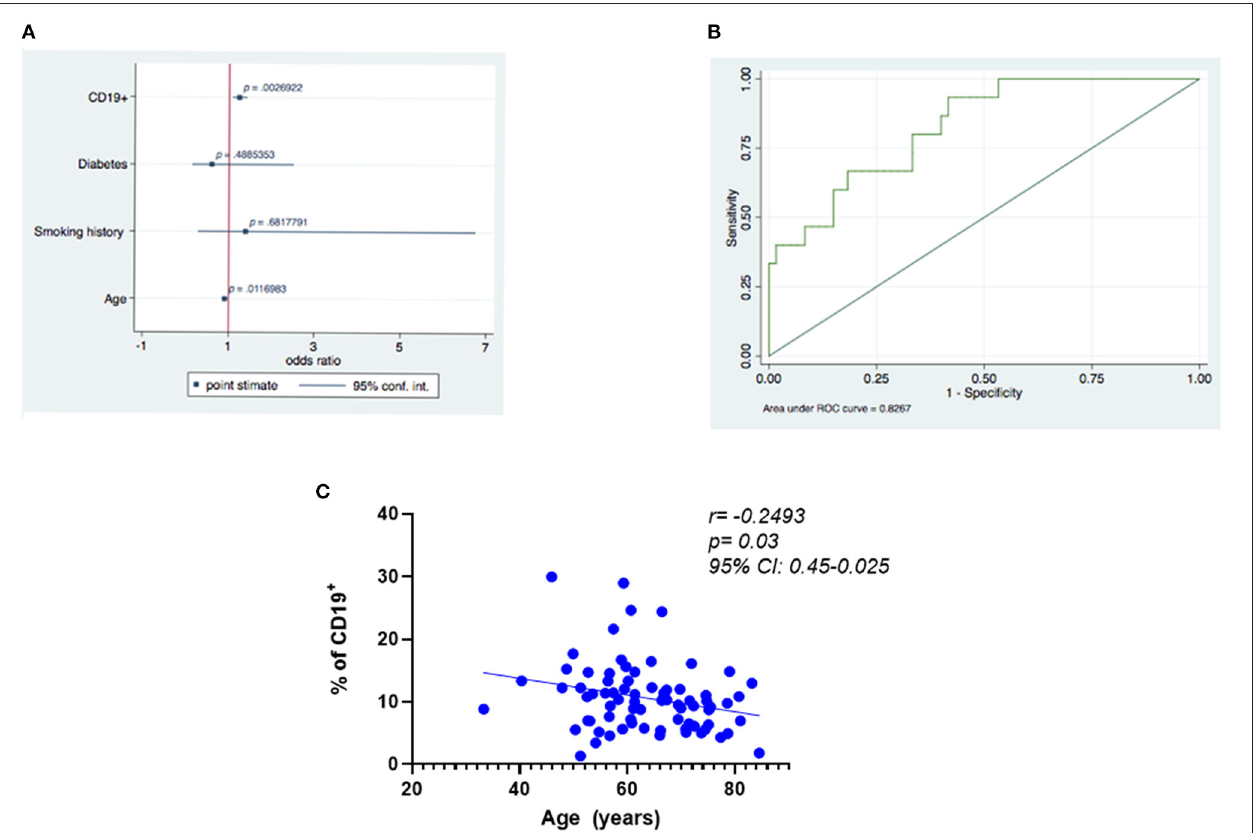
FIGURE 5 | Predictors of best functional outcome using CD19 + cells at baseline. (A) Outcome variable: best functional outcome (increase in LVEF and VO 2 max and decrease in LVESV), multivariate analysis: logistic regression (significance of the model p ≤ 0.001). (B) Receiver operating characteristic (ROC) curves relating to the ability of baseline CD19 + cells to predict improvement in the three functional outcomes was 0.83. (C) Negative correlation between age and the percentage of positive CD19 +